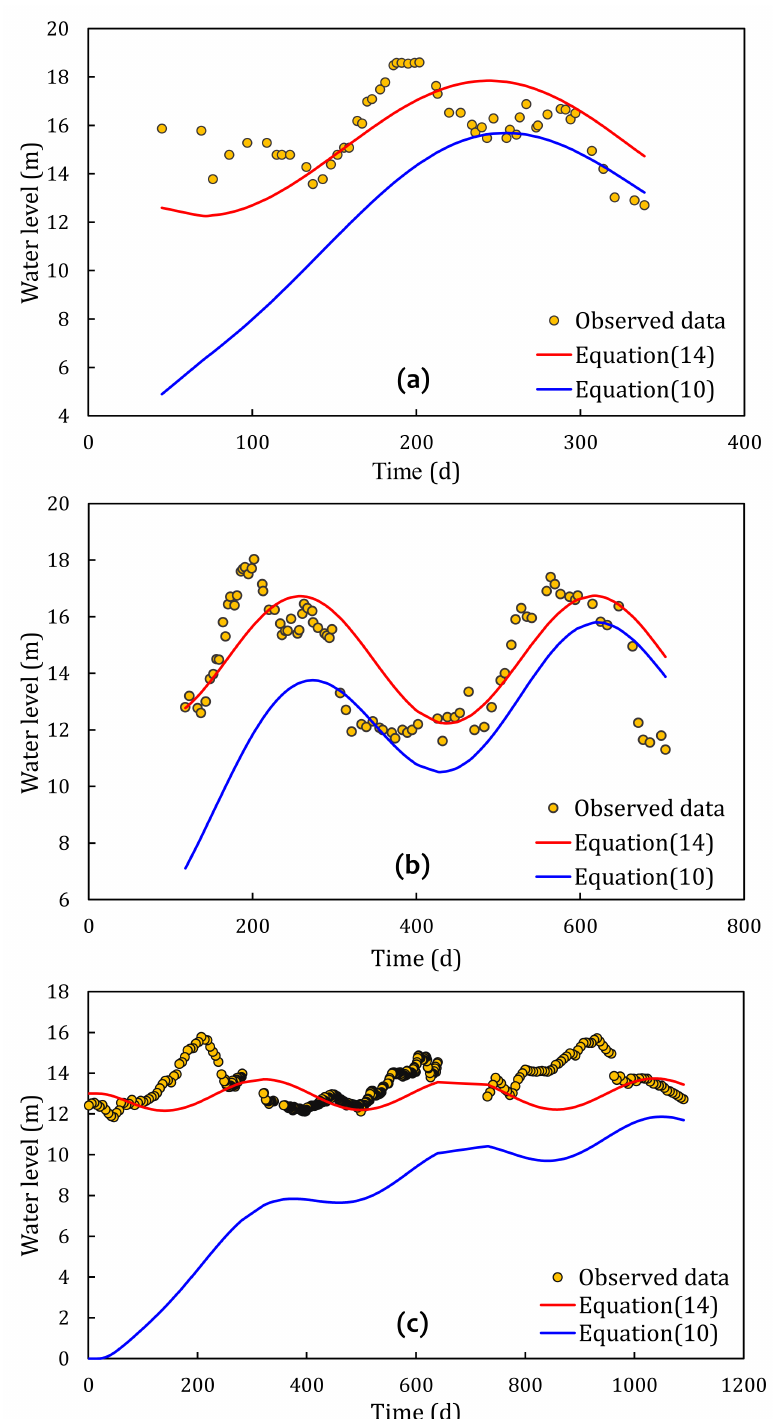
Figure 9. The comparison of calculation results and observed data (monitoring data in ( a – c ) are respectively obtained from SW063, SW016, and